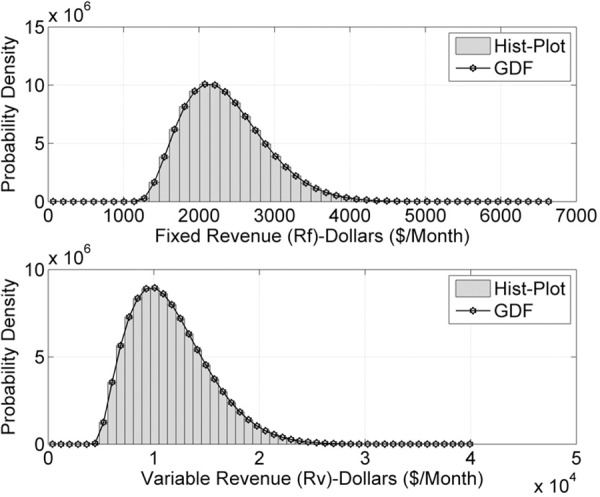
RF(t) and Rv(t) for n = 108 samples.